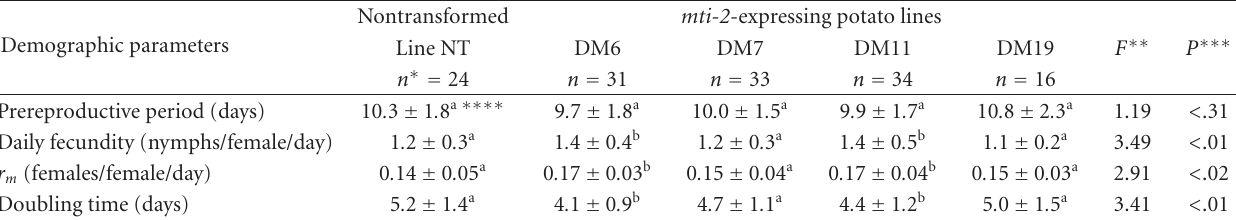
Table 2: Average ( ± s.d.) demographic parameters of Myzus persicae reared on nontransformed (NT) or selected DM lines. Demographic